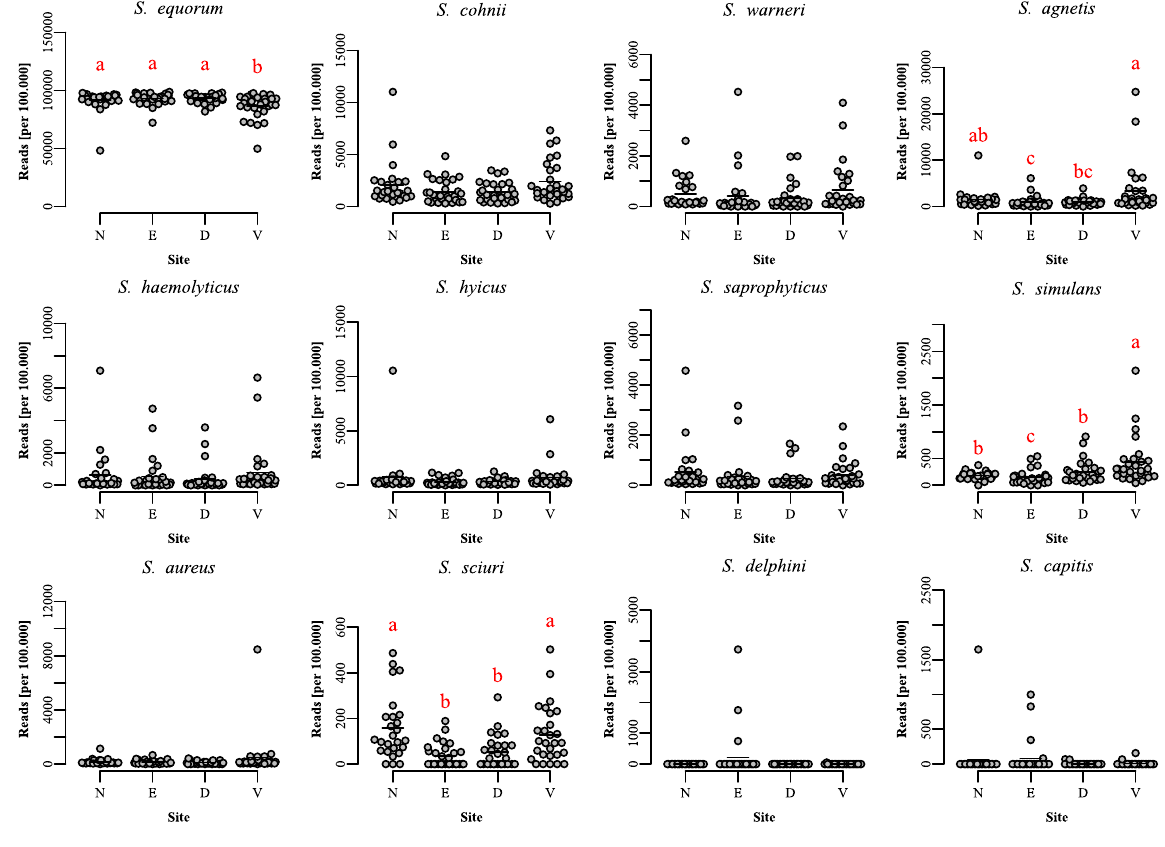
Figure 6. The most abundant and otherwise interesting staphylococcal species from tuf sequencing. N: nose, E: ear, D: dorsal skin surface, V: ventral skin surface. Differences are tested with Kruskal-Wallis and, if significant, different medians are denoted by different letters. P-values are adjusted for multiple comparisons.